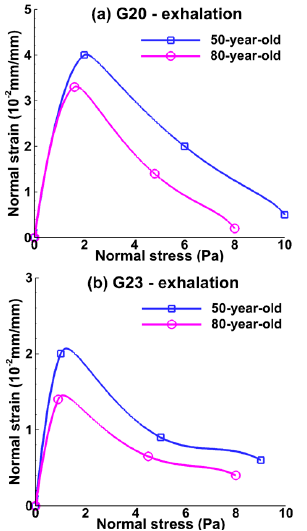
Figure 9. Relationship between normal strain and normal stress during mid-point of exhalation (t = 1.2 s) at ( a ) the bronchiole (G20) and ( b ) the alveolar sac (G23) tissue for the 50-year-old and the